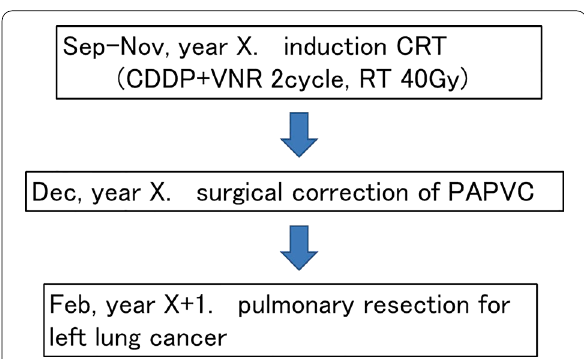
Fig. 5 The time schedule from induction chemoradiation therapy to pulmonary resection in this patient is shown. CRT chemoradiation therapy, CDDP cisplatin, VNR vinorelbine, RT radiotherapy, PAPVC partial anomalous pulmonary venous